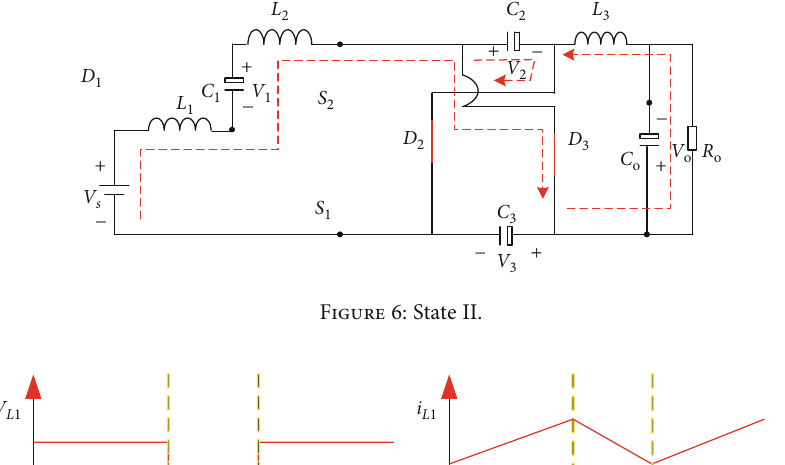
Figure 6: State II.